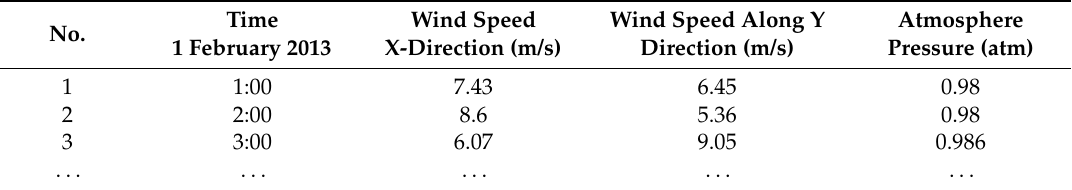
Table 3. Historical numerical weather prediction (NWP) data of a wind